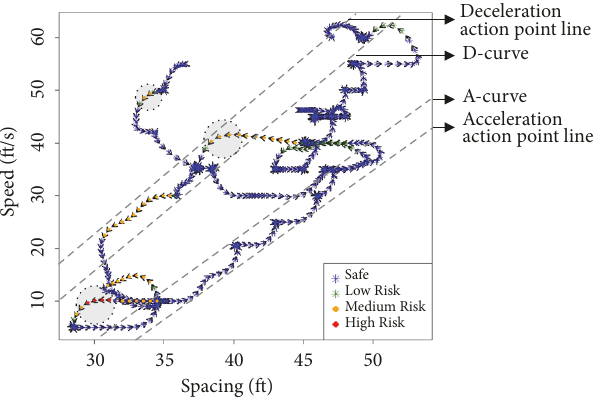
Figure 9: Collision risk estimated with the temporal spacing and speed